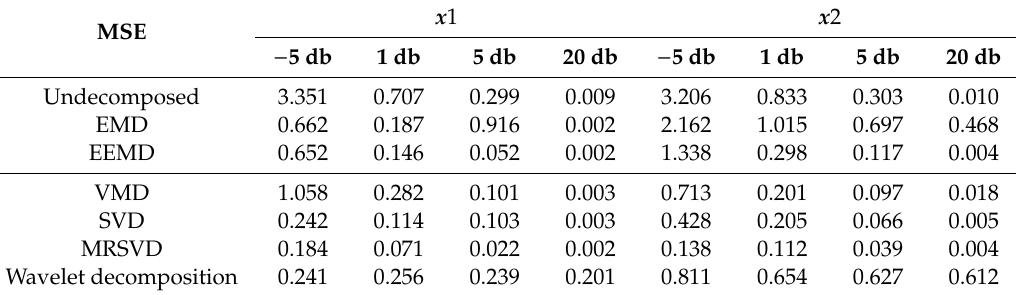
Table 5. MSE of various noise reduction models at different noise powers.